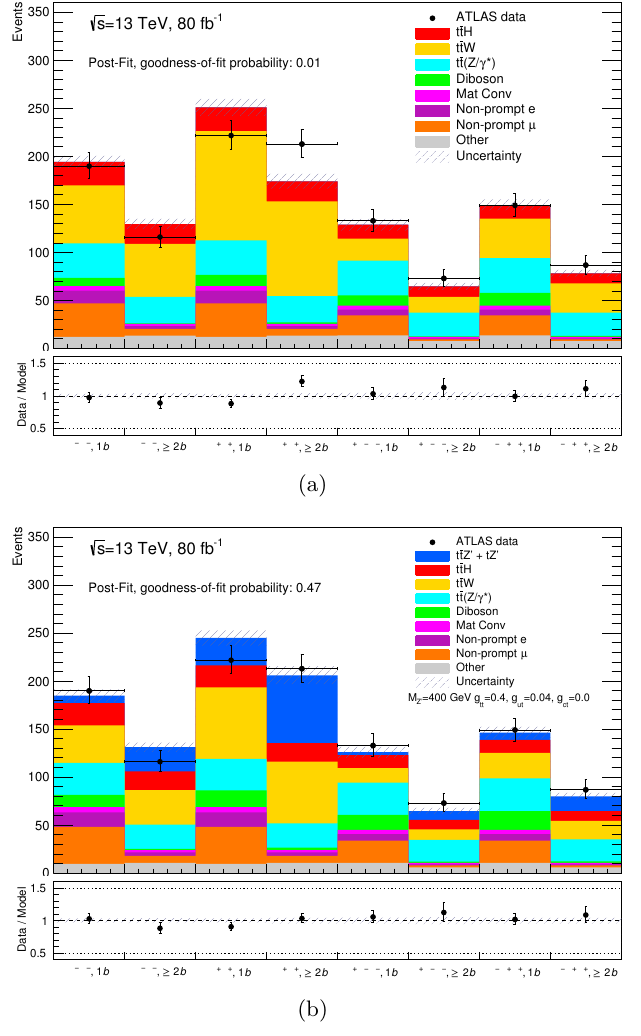
Figure 6 . Comparison between ATLAS data [3] and (a) SM background prediction (b) BSM signal ( tZ 0 + ttZ 0 ) plus SM background prediction for the event yields in 2LSS and 3L channels in categories based on the total lepton charge and the b -jet multiplicity. The BSM signal corresponds to a M = 400 GeV and couplings g = 0 . 04 , g = 0 . 0 and g = 0 . 4 , which minimizes the NLL Z 0 ut ct tt for the ATLAS data [3] for M = 400 GeV. In both cases, we show the SM background prediction Z 0 with fitted NP to the data although the fitted values differ due to the presence of BSM events in